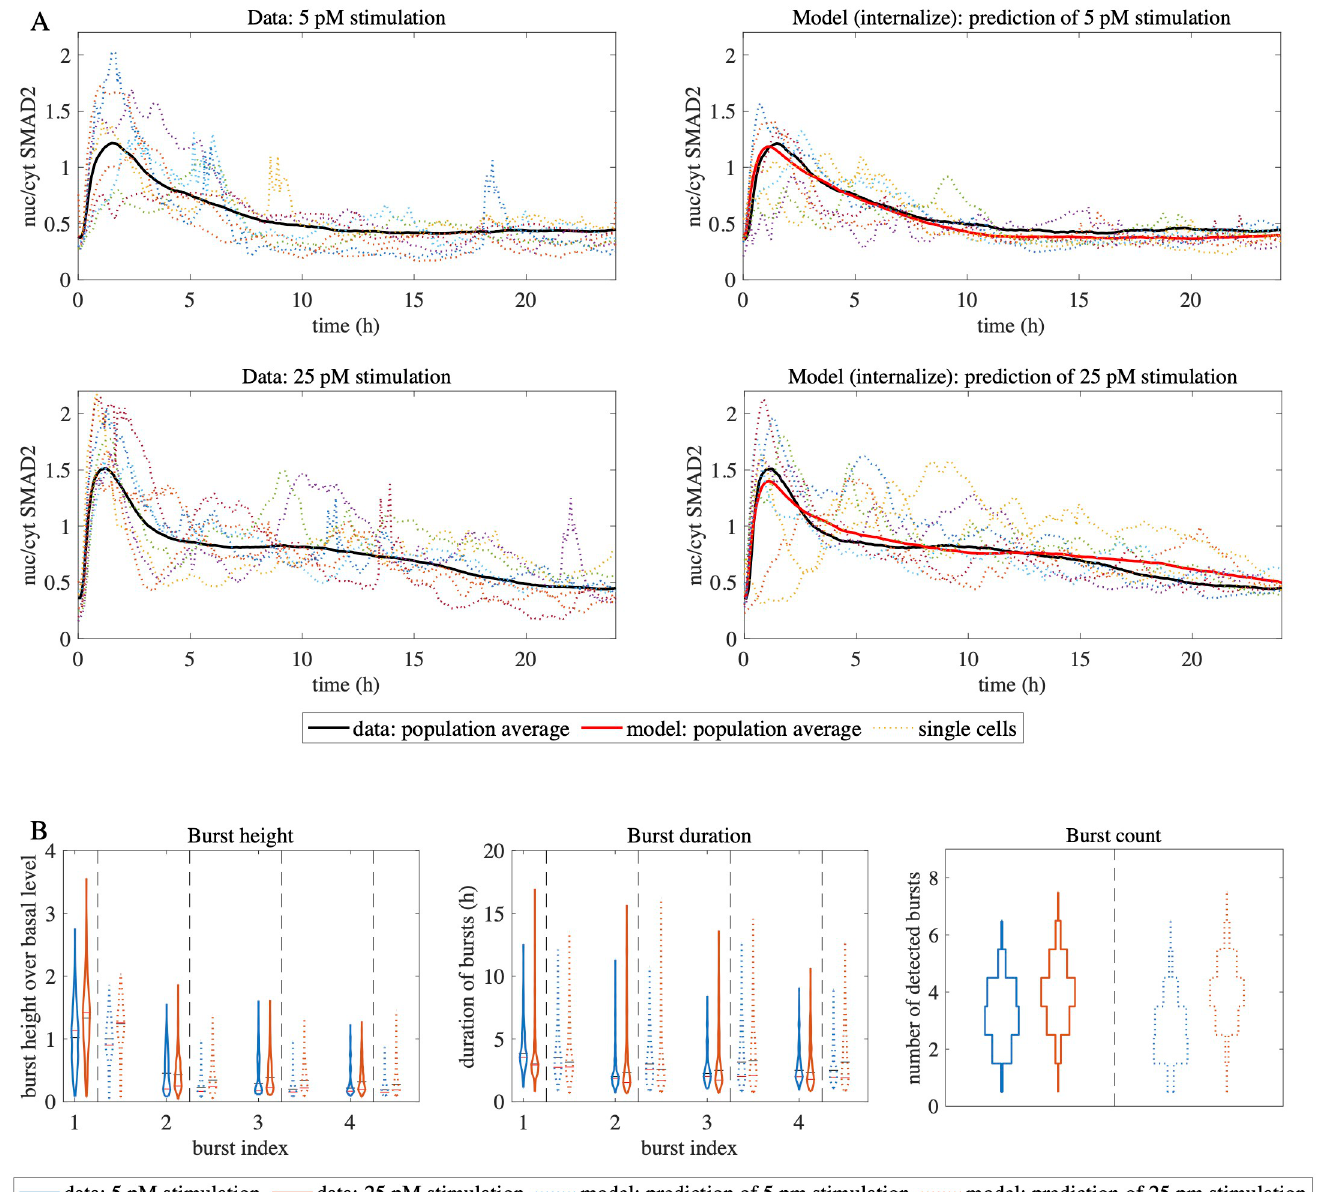
Fig 6. Model accurately predicts stochastic behavior at low TGF- β concentrations. A: Nuc/cyt SMAD2 ratio trajectories of data at low TGF- β doses and corresponding forecast by stochastic model. Single cell and population average of nuc/cyt SMAD2 ratio of the 5 pM and the 25 pM stimulation experiment are shown in the data (left) and the prediction by the best-fit internalization model (right). B: Distributions of burst features in data and forecast by stochastic model. Single cell burst statistics are compared in terms of violin plots for the experimental data (solid lines) and the forecast of the internalization model (dashed lines) in case of stimulation with 5 and 25 pM TGF- β . The mean and the median are indicated by black and red horizontal lines.